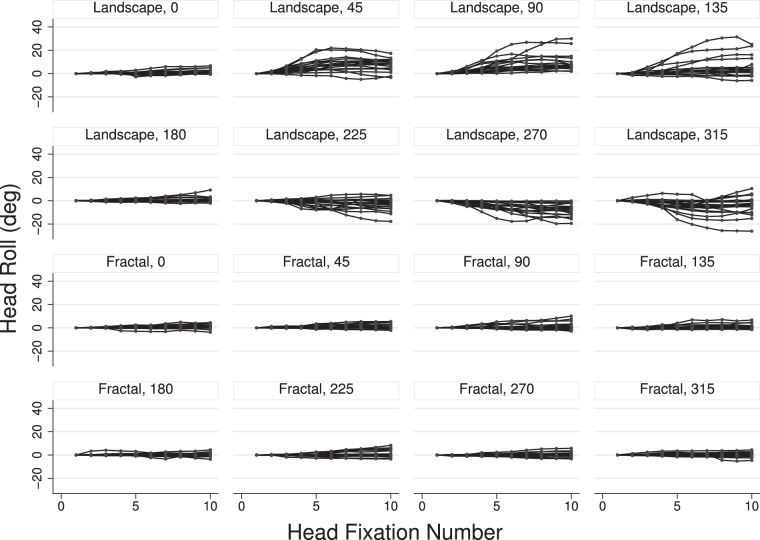
Head rolls as a function of head fixation number. The graphs show individual head roll curves that are normalized relative to the head roll for the first head fixation, with each curve showing head rolls for one participant. The responses for landscape scenes are shown in the top half and for fractal scenes in the bottom half.